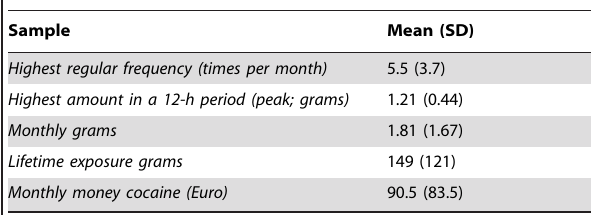
Table 2. Self-reported use of